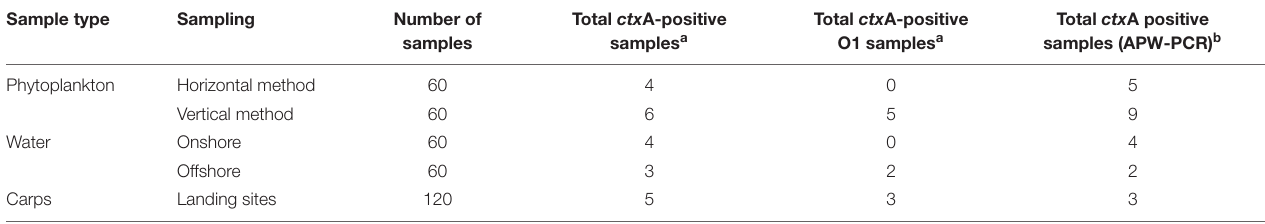
TABLE 1 | Detection of toxigenic V. cholerae O1 by culture and PCR.